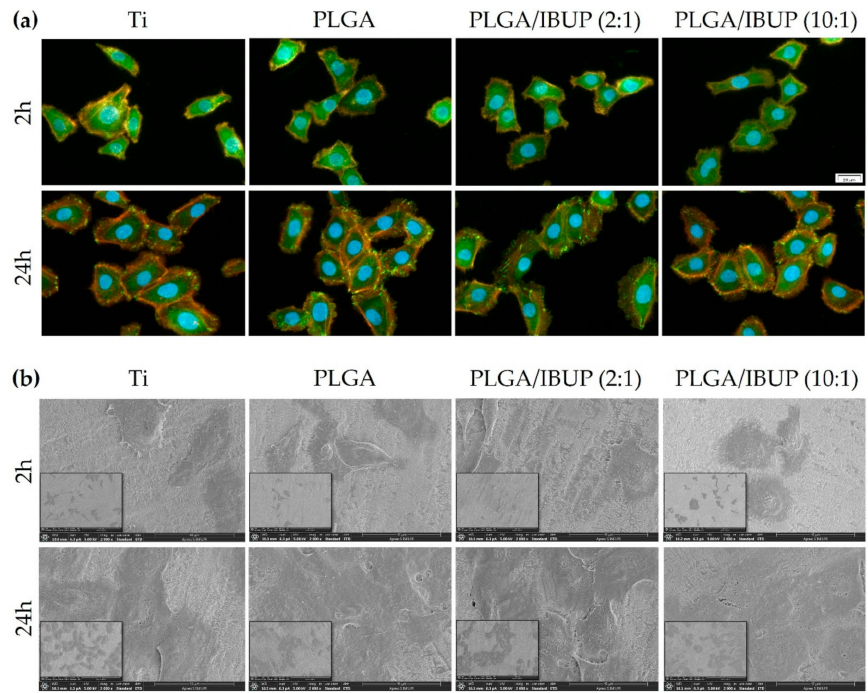
Figure 12. Adhesion and morphology of human keratinocytes on PLGA-based coatings after 2 h and 24 h, evidenced by: ( a ) fluorescence microscopy showing vinculin protein (green), actin filaments (red) and nuclei (blue), scale bar 20 µ m; ( b ) SEM investigation, scale bar 40 µ